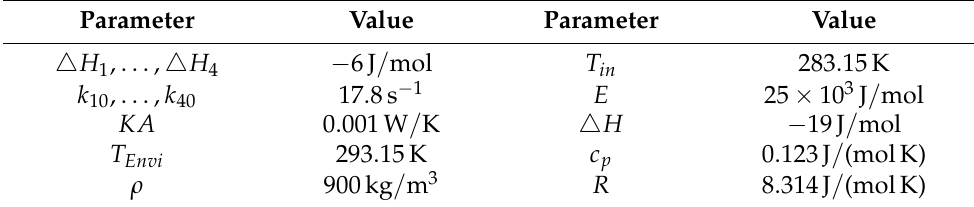
Table 4. Parameter values used in plant